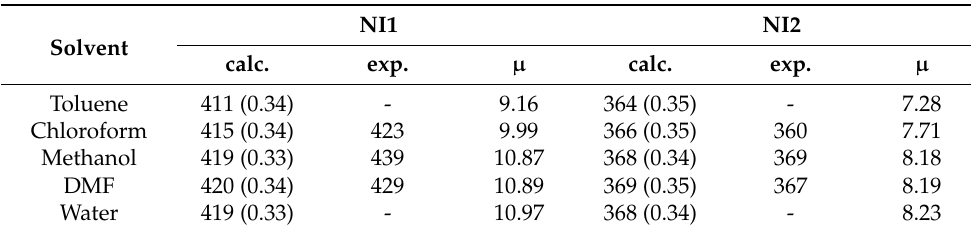
Table 5. TDDFT calculated absorption wavelengths ( λ abs , nm), oscillator strength f (in parentheses), and dipole moments (μ, Debye) for NI1 and NI2 in solvents of different polarity: toluene, chloroform, methanol, DMF, and water. NI1 NI2 calc.